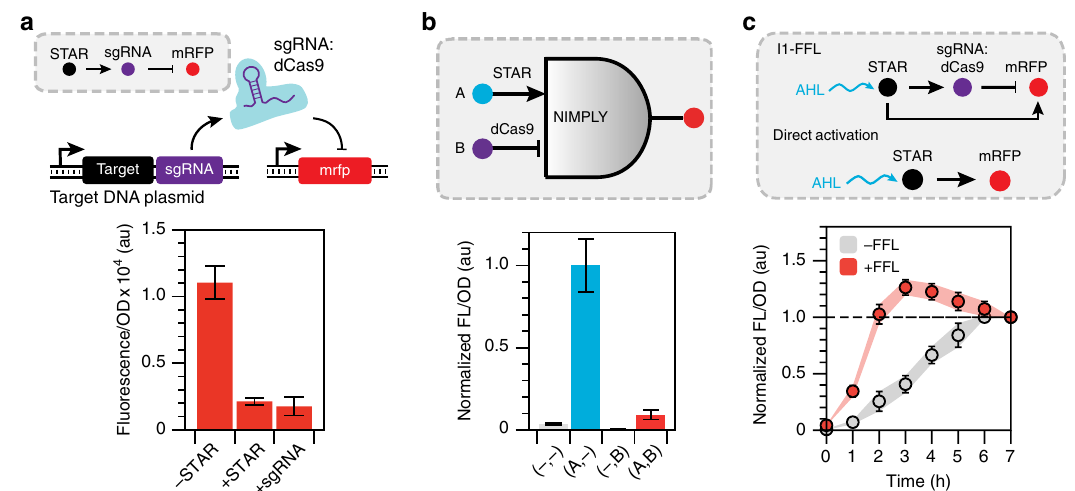
Fig. 6 STARs and CRISPRi create new types of dynamic network motifs. a STARs function with CRISPRi in an RNA activation-repression cascade. Schematic of the DNA template of a STAR regulated CRISPRi cascade. Fluorescence characterization was performed on E. coli cells transformed with a dCas9 and target RNA-mRFP expressing plasmid and a STAR-regulated single guide RNA (sgRNA) plasmid in the absence (-STAR) and presence (+STAR) of a plasmid encoding the cognate STAR. A constitutively expressed sgRNA (+sgRNA) was used as a control. Detailed schematic and full experimental controls are shown in Supplementary Fig. 20. b STARs function with CRISPRi in logic gates. Schematic of a STAR and CRISPRi based NIMPLY (A AND NOT B) logic gate (see Supplementary Fig. 21 for a detailed schematic). Fluorescence characterization was performed on E. coli cells transformed with a plasmid encoding the NIMPLY logic gate and sgRNA in the presence of plasmids encoding all combinations of input A (STAR) and input B (dCas9). Fluorescence data were normalized to 1 for the ON condition (Input A only). c A STAR-CRISPRi incoherent type 1 feed-forward loop (I1-FFL) creates accelerated response and a pulse of gene expression. Schematic of the STAR-CRISPRi I1-FFL and direct activation control (see Supplementary Fig. 21 for a detailed schematic). Fluorescence characterization of E. coli cells transformed with a plasmid encoding the I1-FFL ( + FFL) or the direct activation (-FFL) cascade. STAR expression was induced at time 0 h by addition of AHL and fl uorescence measured every 1 h for 7 h. No AHL controls are shown in Supplementary Fig. 22. Fluorescence data for each condition were individually normalized by dividing by the fi nal fl uorescence values at 7 h for each colony before calculating the mean and s.d. at each time point. Fluorescence characterization was performed by bulk fl uorescence measurements (measured in units of fl uorescence [FL]/optical density [OD] at 600 nm). Data in a , b represent mean values and error bars represent s.d of n = 9 biological replicates, and data in c represent mean values and error bars represent s.d of n = 3 biological replicates with repeats shown in Supplementary Fig.